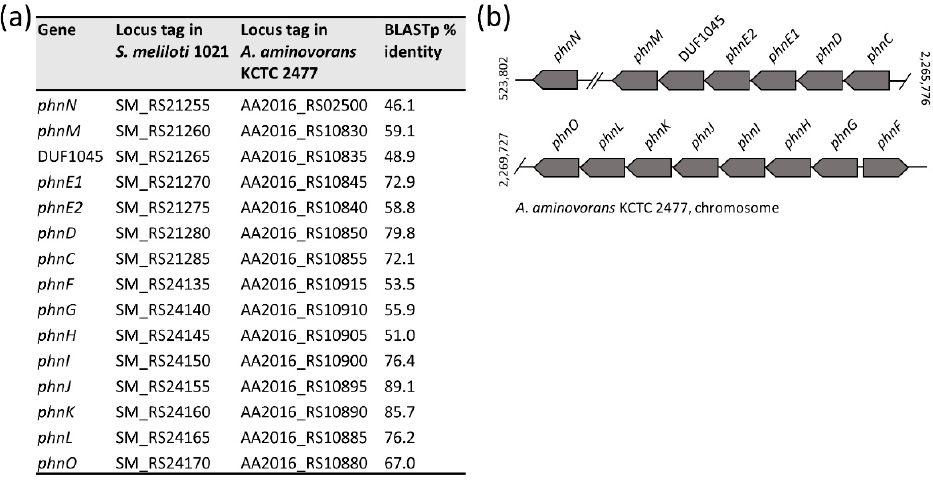
Figure 9. ( a ) Summary results of BLASTp comparison of translated nucleotide sequences from glyphosate oxidation genes from S. meliloti 1021 and A. aminovorans KCTC 2477; ( b ) Glyphosate oxidation genes organization of A. aminovorans KCTC 2477; phnGHIJKLM core genes of the C-P lyase enzyme system; phnCDE1E2 , phosphonate transporter subunits; phnN , ribosyl bisphosphate phosphokinase; phnF , transcription regulator; phnO , aminoalkylphosphonate N-acetyltransferase; DUF1045, putative phosphoribosyl cyclic phosphodiesterase ([26]; see also MetaCyc Pathway: glyphosate degradation III, https://biocyc.org/META/NEW-IMAGE?type=PATHWAY&object=PWY-7807 last accessed on 14 May 2021). Double slash marks denote regions that are not shown. Coordinates are numbered according to the first base of the genome. The gene map is not to